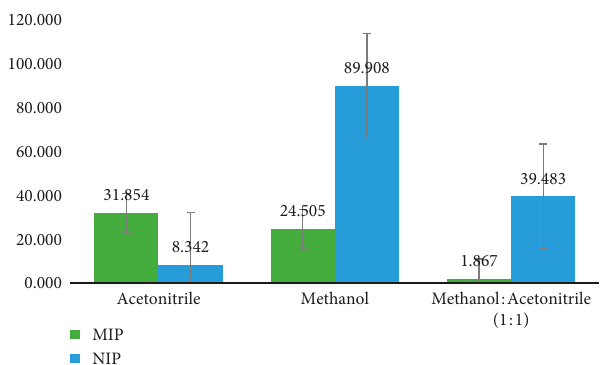
Figure 2: Binding ability MMA propanol polymer bulk method ( n � 3).